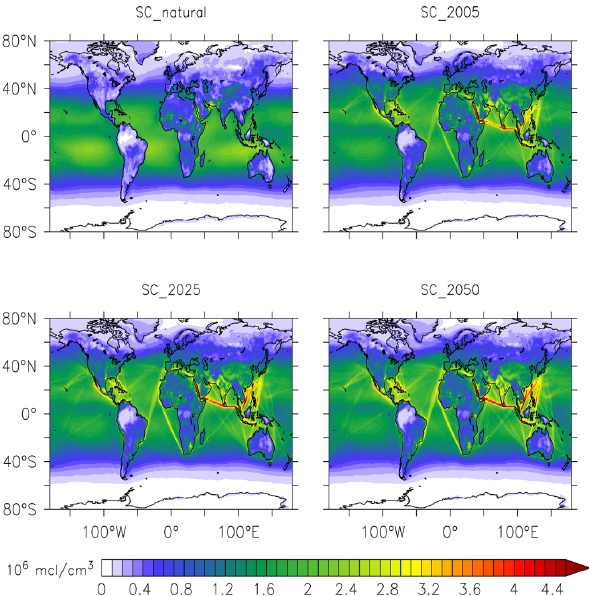
Fig. 7. Model calculated annual mean surface hydroxyl radical concentration in 10 6 cm − 3 from simulation SC natural , SC 2005 , SC 2025 and SC 2050 .